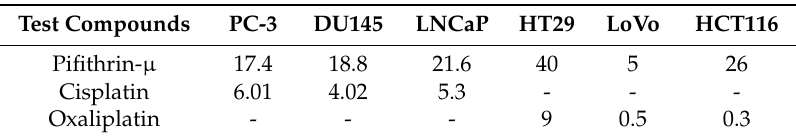
Table 1. IC 50 ( µ M) values calculated for cisplatin, oxaliplatin or pifithrin- µ against prostate and Table 1. IC 50 ( μ M) values calculated for cisplatin, oxaliplatin or pifithrin- μ against prostate and colorectal cell lines on 72 h treatment ( n = colorectal cell lines on 72 h treatment ( n = 3).